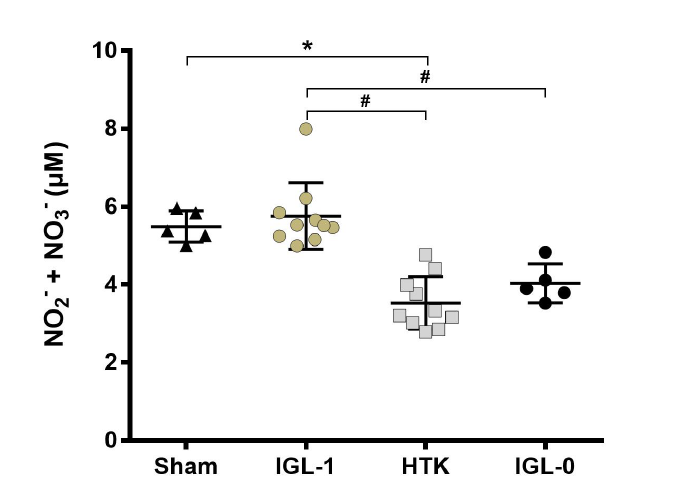
Figure 4. Nitrites/Nitrates expression after 24 h cold ischemia in steatotic livers. NO 2 − /NO 3 − concentration was measured using a kit. HTK group production of NO 2 − /NO 3 − was greatly reduced compared to Sham and IGL-1. The same decrease in the production of NO was observed when the PEG35 was removed (IGL-0) compared to IGL-1. NO 2 − /NO 3 − in fatty liver preserved 24 h in IGL-0 was almost double compared to the Sham group. Results are presented as mean (SD), IGL-1/HTK n = 10/group, Sham/IGL-0 n = 5/group, * p < 0.05 vs. Sham; # p < 0.05 vs. IGL-1 (One-way